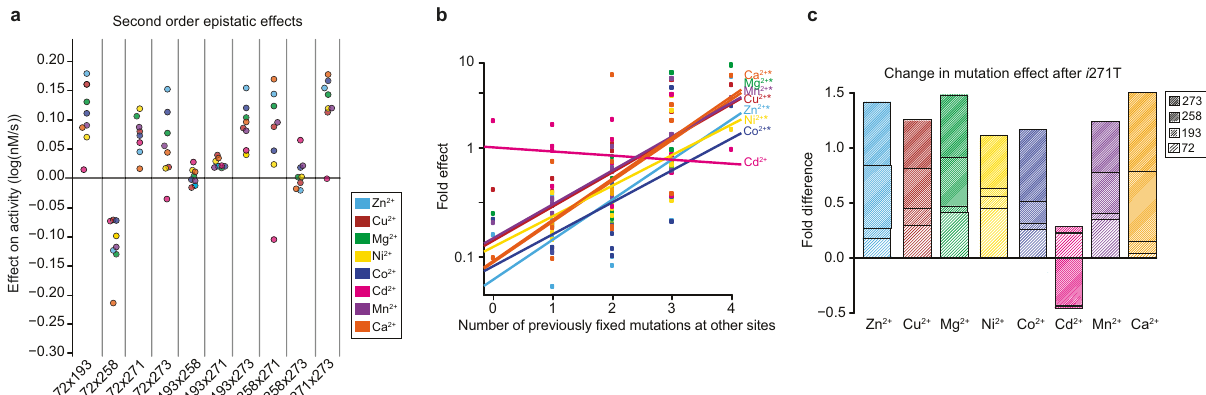
Fig. 5 Changes in epistatic interactions. a The pairwise epistatic interaction effects for each metal environment. The two interacting residues are denoted on the x-axis by their positions, with an “ x ” in between them (e.g., 72 × 193 denote the pair-wise effects of mutations at positions 72 and 193). b The relationship between the effect of mutating position 271 and the number of previously fi xed substitutions at other sites for each metal. Symbol (*) denotes a statistically signi fi cant correlation ( p < 0.05 after correcting for multiple tests). c The impact of previous substitutions at positions 72, 193, 258. and 273 on the effect of the substitution at position